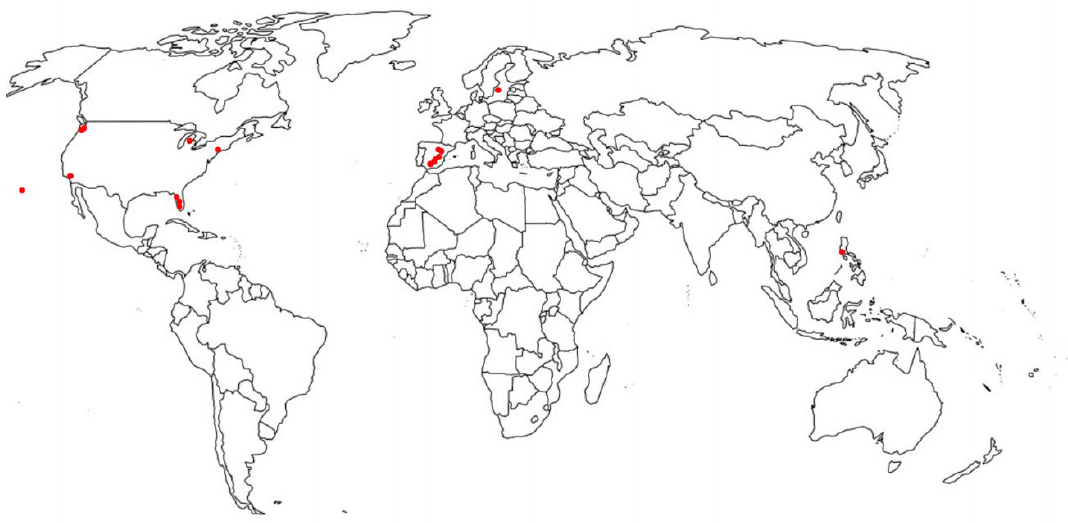
Figure 3. Geographic locations of animals which parabens were found.